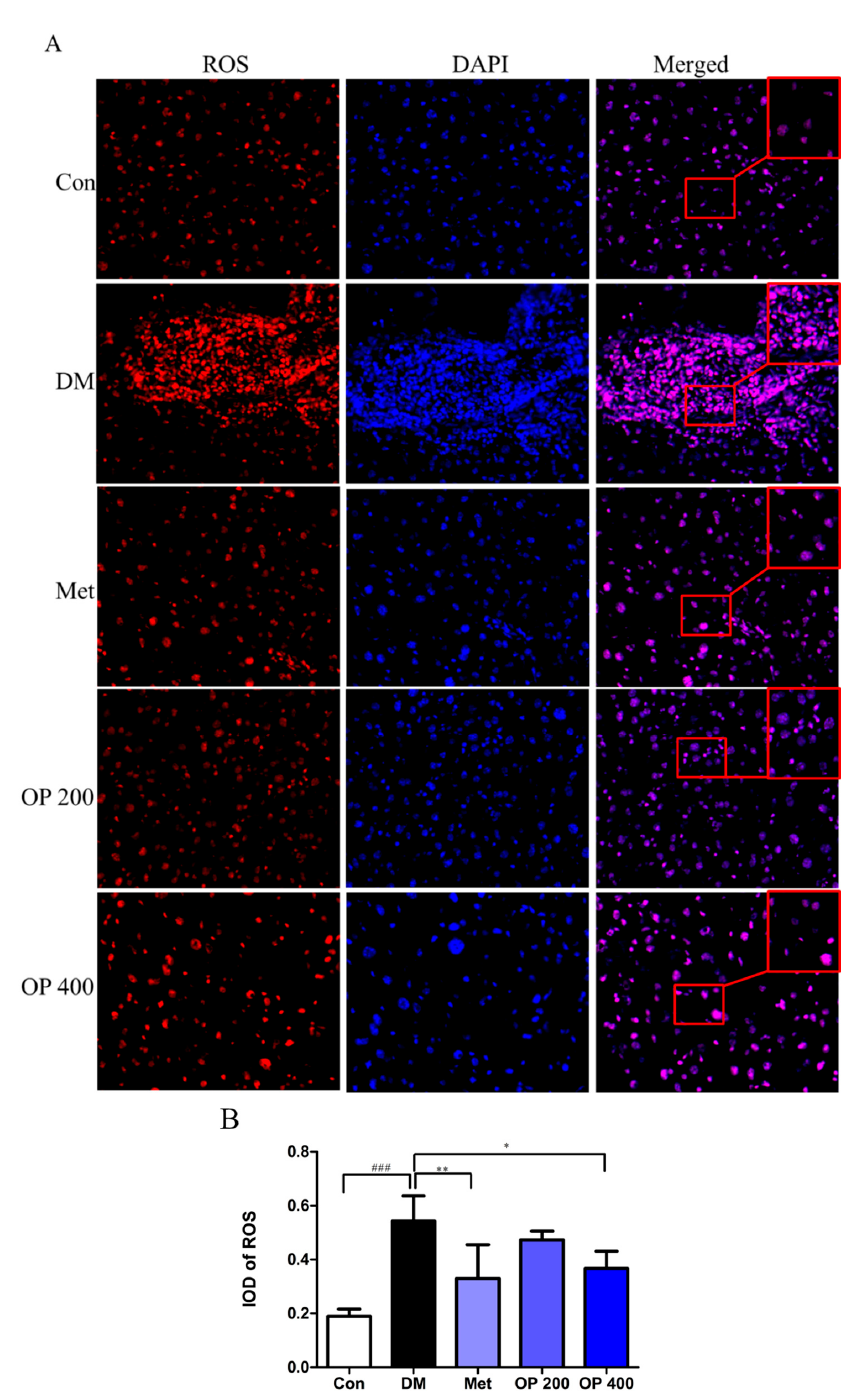
Figure 6. Effect of OP on reactive oxygen species (ROS) in the liver. ( A ) Liver were stained with specific antibodies against ROS (red). Nuclei were stained with 4',6-diamidino-2-phenylindole (DAPI) (blue). ( B ) The IOD of ROS. Results are expressed as mean ± SEM (n = 3). ### p < 0.001 vs control, * p < 0.05, ** p < 0.01 vs model.